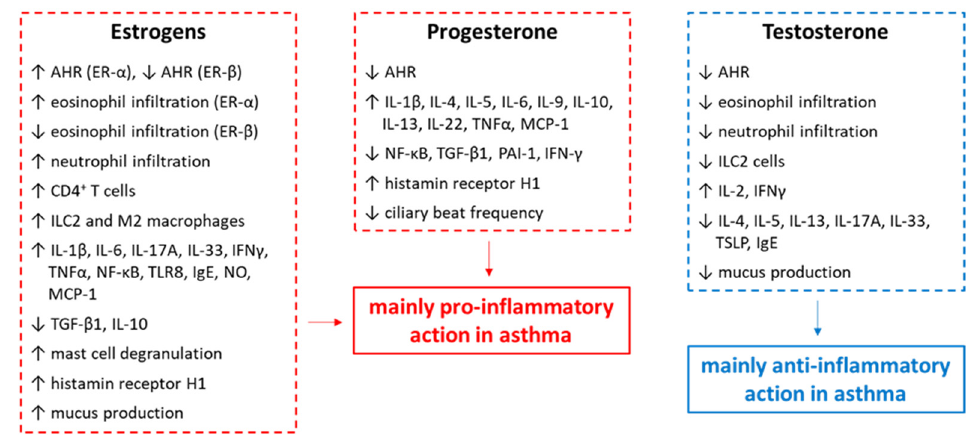
Figure 2. Outline of the actions of estrogens, progesterone, and testosterone in bronchial asthma.